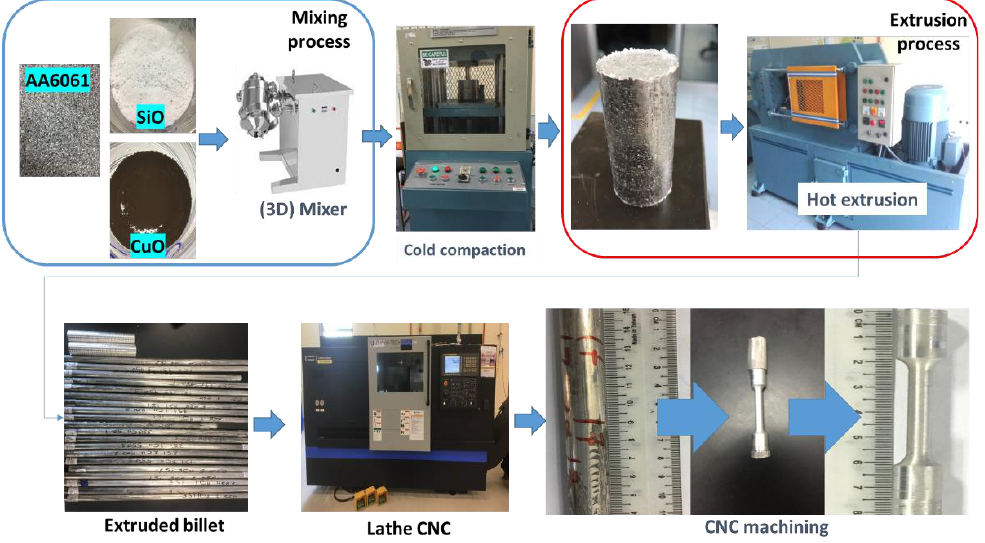
Figure 1. Process sequence of billet life.